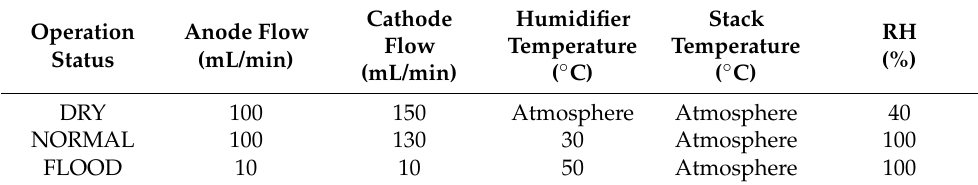
Table 2. PEMFC operating conditions in the three